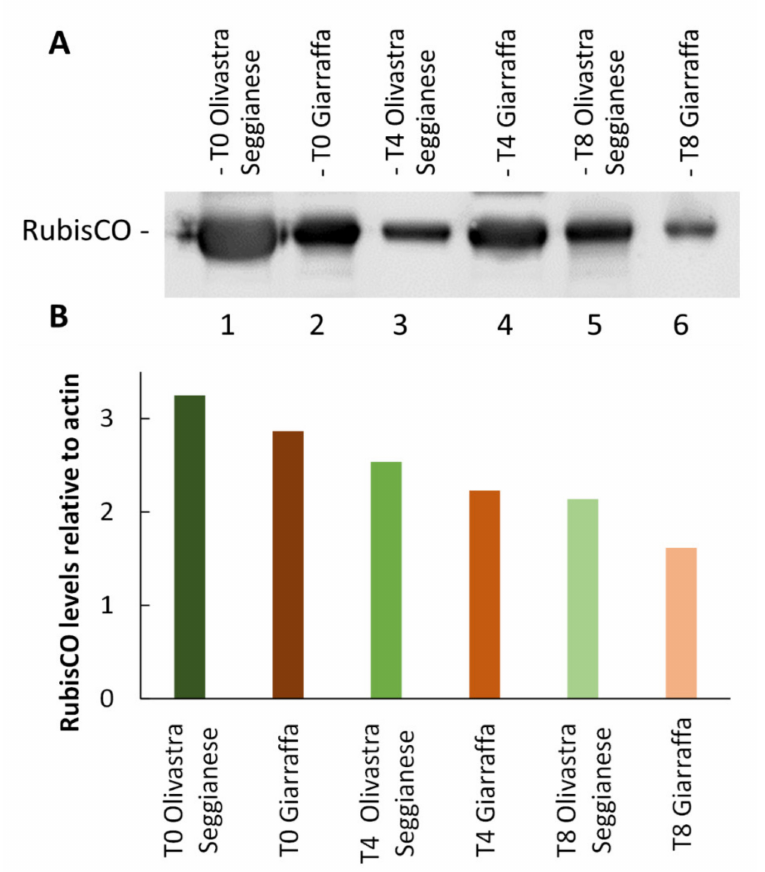
Figure 8. Analysis of RubisCO content. ( A ) Electrophoresis and immunoblotting with anti-RubisCO antibody on proteins extracted from Giarraffa and Olivastra Seggianese plants, subjected to UV-B stress and collected at T0, T4, and T8. Lane 1: Olivastra Seggianese at T0. Lane 2: Giarraffa at T0. Lane 3: Olivastra Seggianese at T4. Lane 4: Giarraffa at T4. Lane 5: Olivastra Seggianese at T8. Lane 6: Giarraffa at T8. ( B ) Graph of the relative quantification of immunoblot intensities for RubisCO relative to the actin